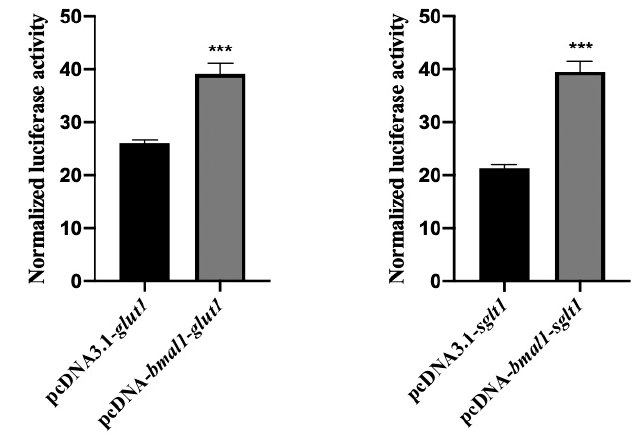
Figure 3. Overexpression of BMAL1 in vitro significantly activated the expression of GLUT1 and SGLT1 in L. vannamei . Each bar represents the mean ± SD ( n = 4). Bars assigned with asterisks are significantly different. *** indicated p < 0.001.